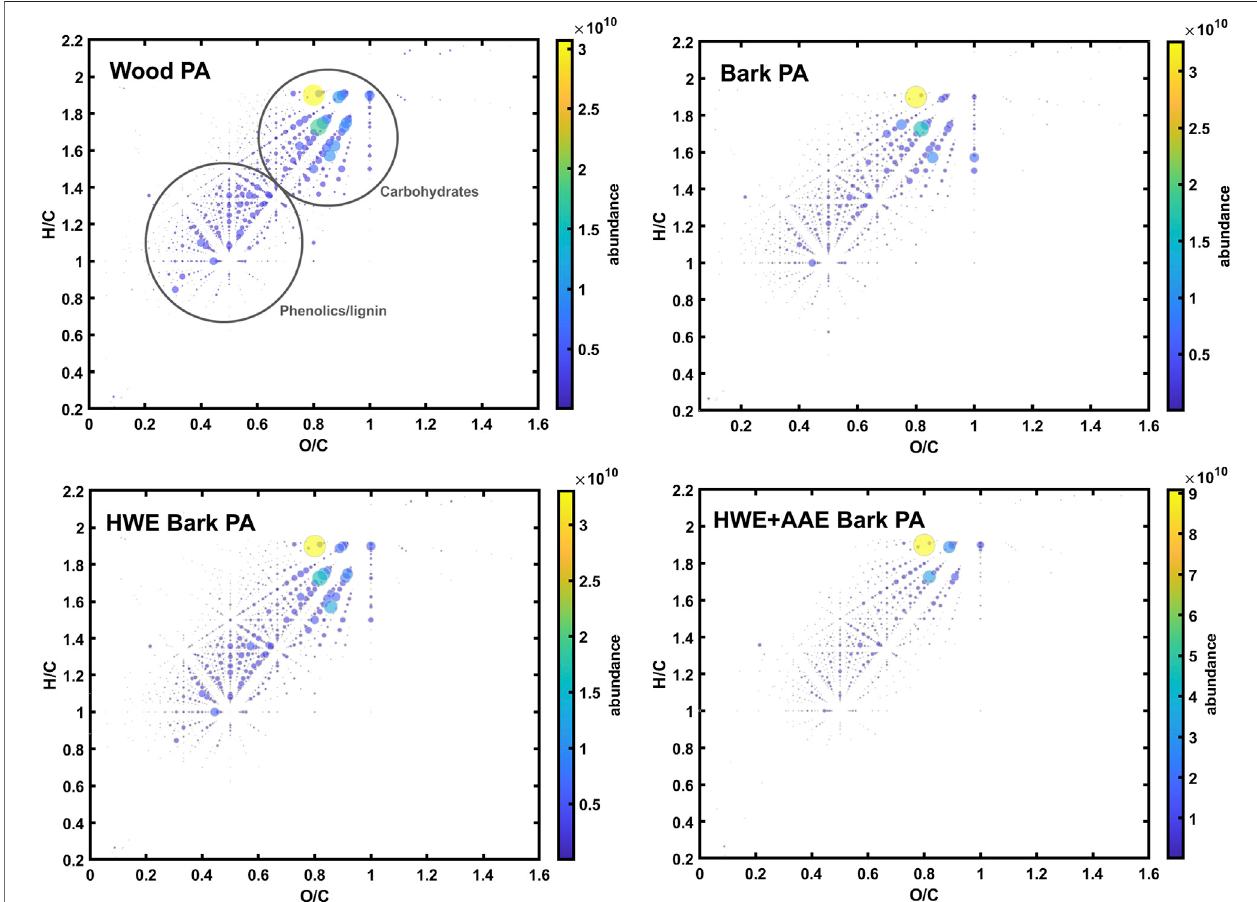
FIGURE6| VanKrevelendiagramsforthecompoundsdetectedindifferentconversiondistillateswithnegative-ionionelectrosprayionizationFouriertransformion cyclotron resonance (ESI-FT-ICR) mass spectrometry. The dot size / color represents the relative abundance of each detected compound.